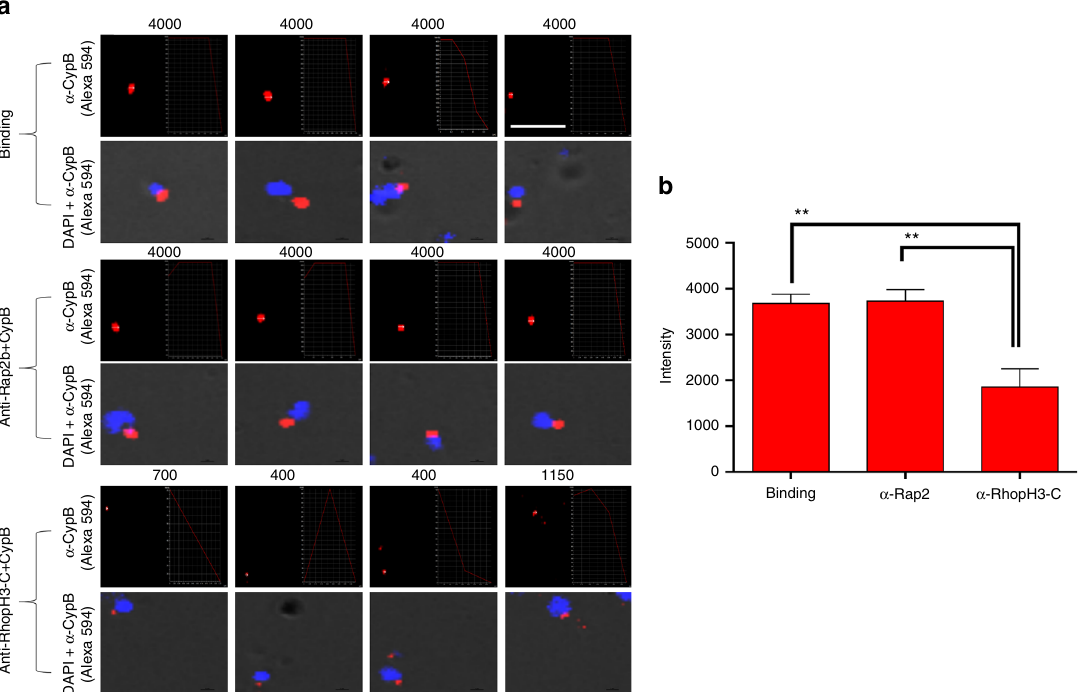
Fig. 2 PfRhopH3 protein is a ligand for Cyclophilin B protein during merozoite binding. a Binding of Cyclophilin B on Merozoite surface. Binding shows binding of CypB on merozoite surface without treatment with any antibody. anti-Rap2b + CypB and anti-RhopH3-C + CypB show binding after treatment with anti-Rap2b and anti-RhopH3 antibody respectively. Intensity for each merozoite is mentioned at the top. Images with histograms represent only the intensity of the bound CypB protein. Anti-RhopH3-C antibody interferes with binding of CypB on merozoites, signifying that PfRhopH3 is a ligand for host Cyclophilin B. Scale bar = 5 µ m. b Graph adapted from Supplementary Table 1 showing the average of binding intensity of CypB on 10 different merozoites, with error bars representing the standard deviation. All values were tested for signi fi cance using a two-tailed unpaired Student ’ s t -test. ** P <